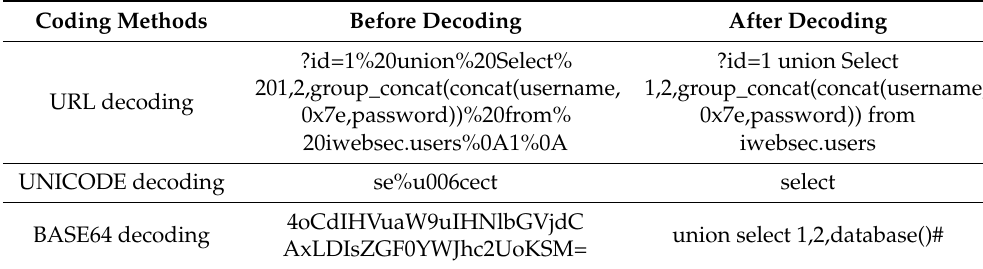
Table 4. Decoding methods and examples. Coding Methods